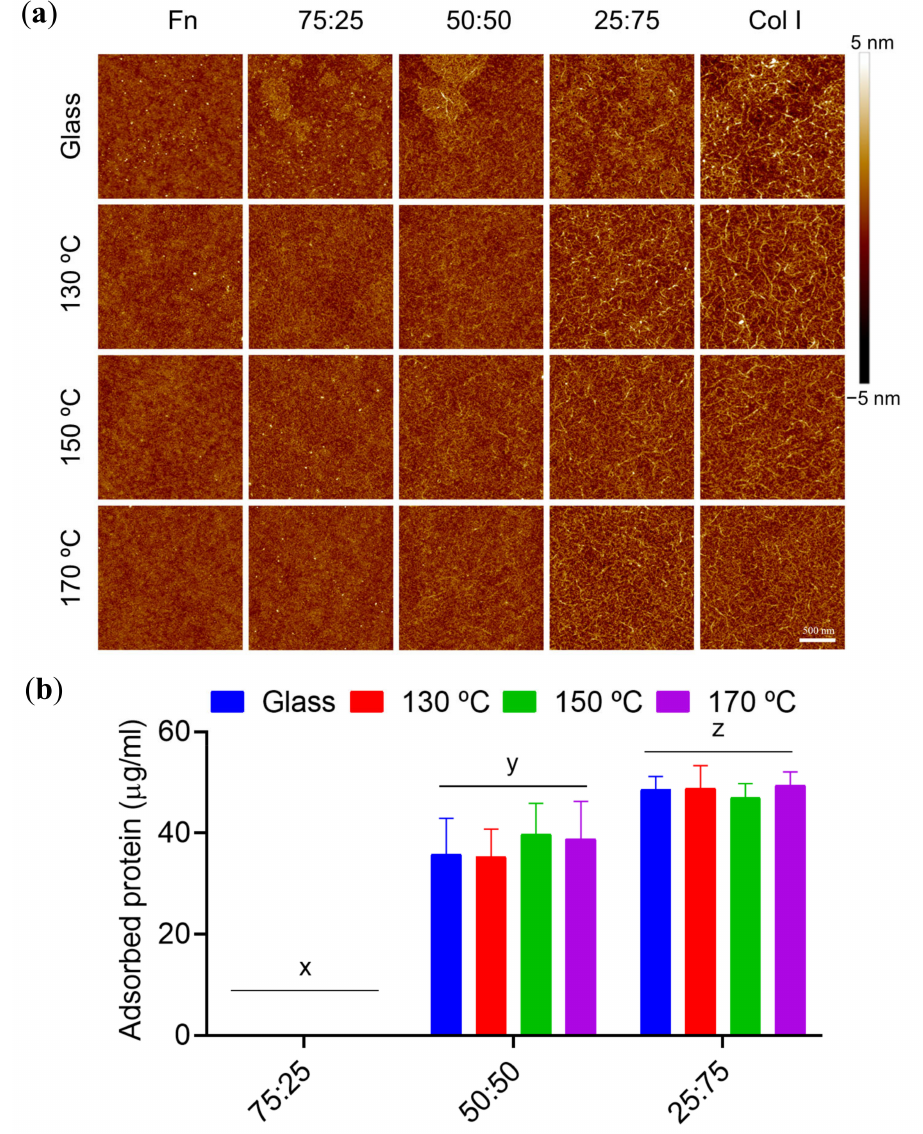
Figure 5. Protein competition adsorption on PGS substrates. ( a ) AFM height images of 2 × 2 µ m 2 and ( b ) protein adsorption quantification from microBCA colorimetric experi- ments after competition adsorption assays with Fn and Col I on glass and PGS cured at different temperatures. The indicated percentages of intermediate protein mixtures are volumetric ratios of Fn 10 µ g/mL over Col I 40 µ g/mL. All images share the scale bar of 500 nm. Sample data distributions were analysed through a two-way ANOVA and Bonferroni post hoc multiple mean comparison test, with a p -value of